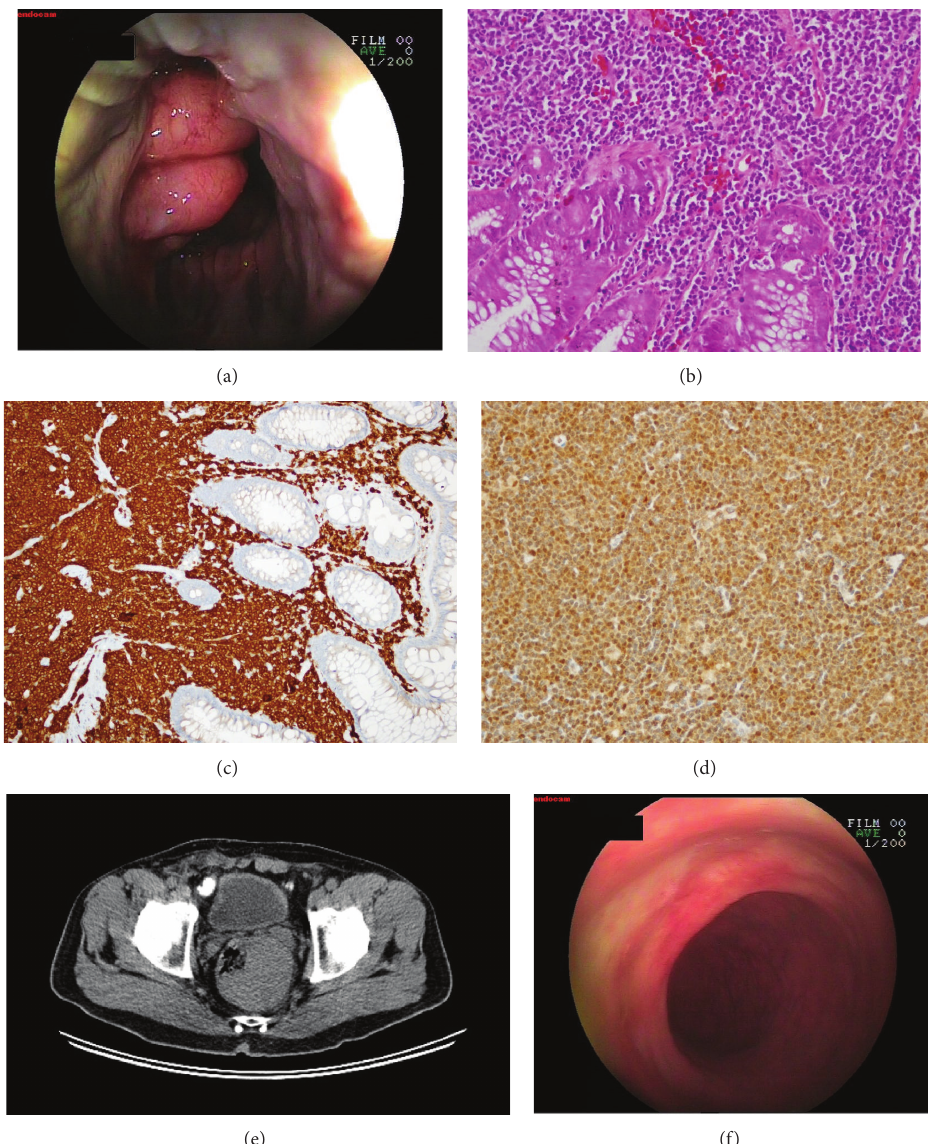
Figure 1: (a) Protruding mass adjacent to the anal canal. (b) Atypical lymphocytes infiltrating the hematoxylin-eosin-stained lamina propria and the surface epithelium in certain locations (original magnification × 40). (c) Cd79a-strained atypical lymphocytes infiltrating the lamina propria and the surface epithelium in certain locations (original magnification × 40). (d) Cyclin D1-positive atypical lymphocytes infiltrating the lamina propria (original magnification × 40). (e) Abdominal tomography. The 6 × 8 cm mass on the left-side wall of the rectum and